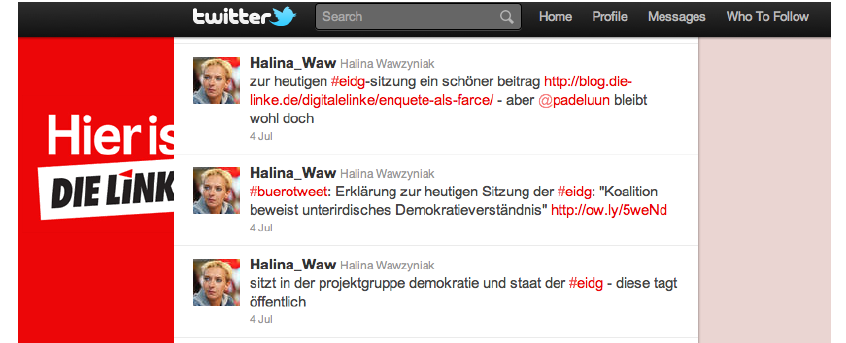
Figure 3: Twitter profile of Halina Wawzyniak (Member of German